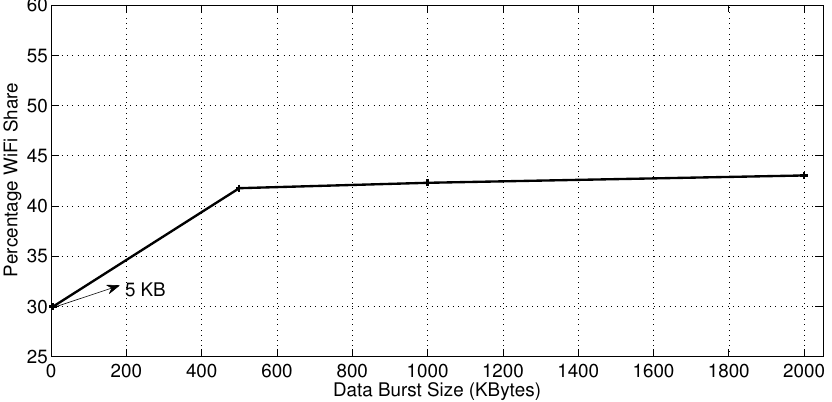
Figure 10. WiFi share with different burst sizes.